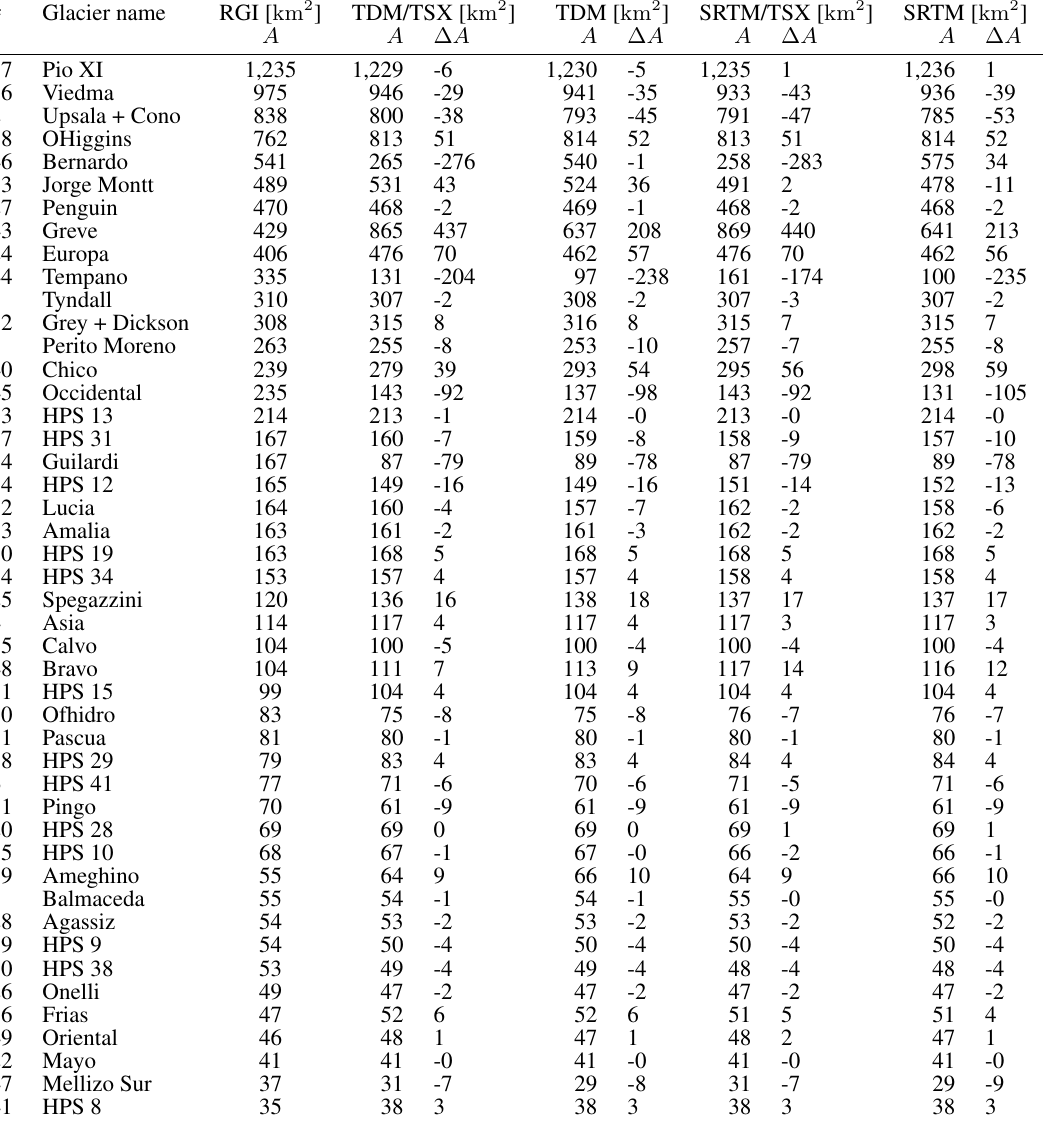
Table 1. Drainage basin areas A and their respective differences to the RGI delineation (e.g. TDM/TSX - RGI) ∆ A for each numbered glacier as in Figure